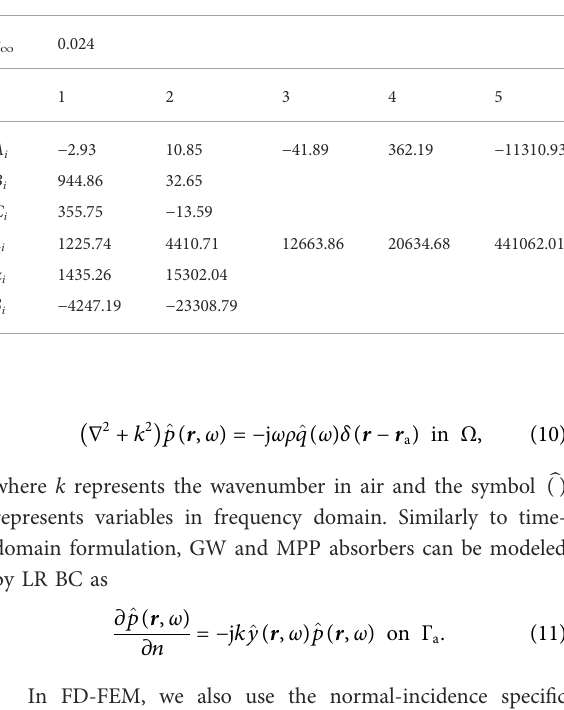
TABLE 1 Parameters y ∞ , A i , B i , C i , λ i , α i , and β i for MPPGW panel. The parameters were fi tted at 10 Hz — 10